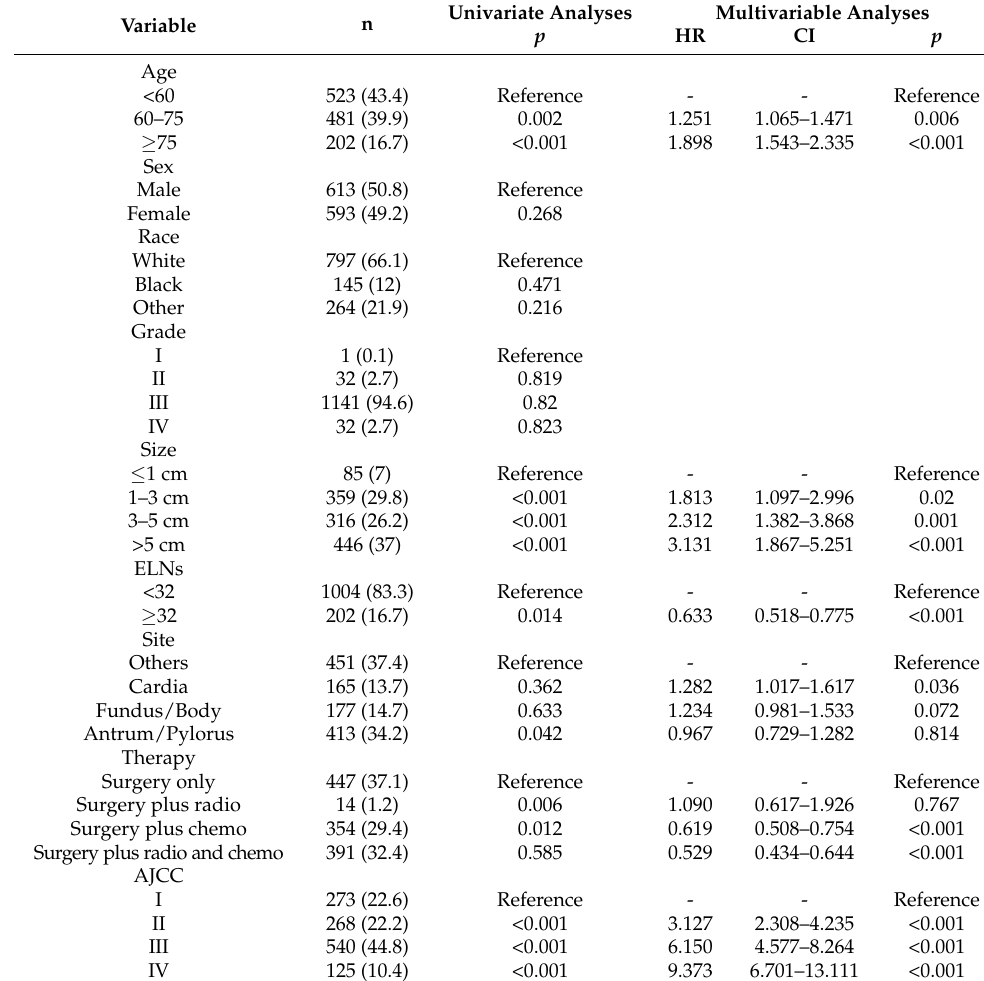
Table 4. Univariate and multivariable analyses in the derivation